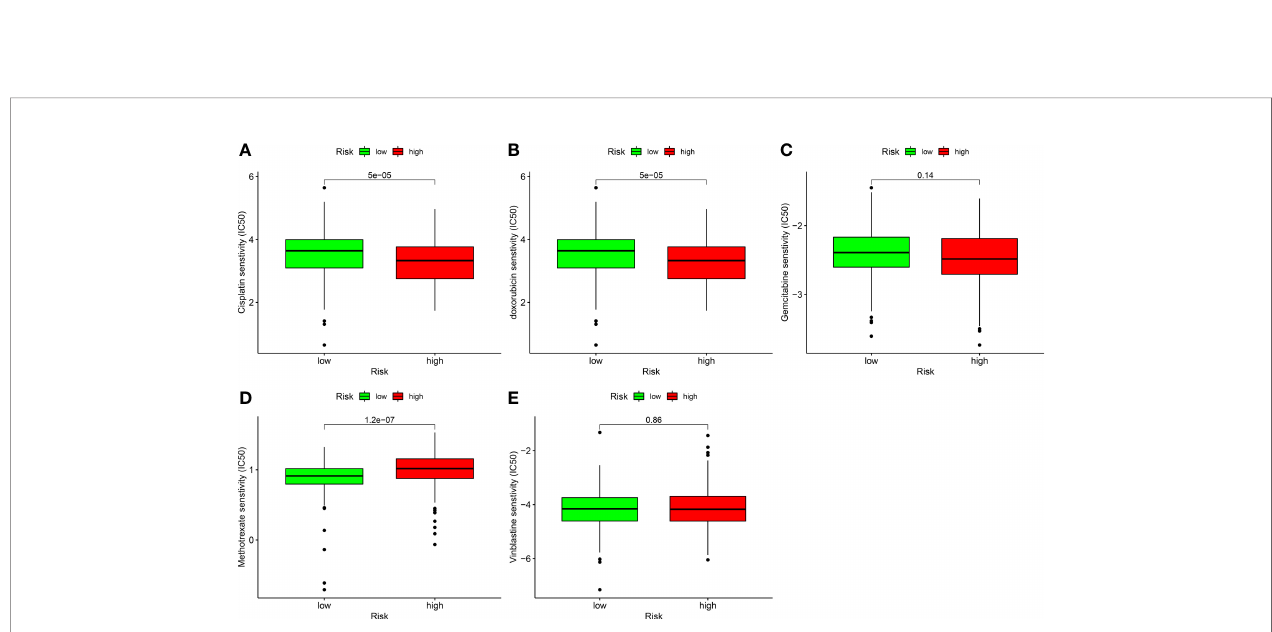
FIGURE 9 | Correlation analysis between risk models and chemotherapy drugs for BLCA. Comparing the IC 50 values of (A) cisplatin, (B) doxorubicin, (C) gemcitabine, (D) methotrexate, and (E) vinblastine in high- and low-risk BLCA